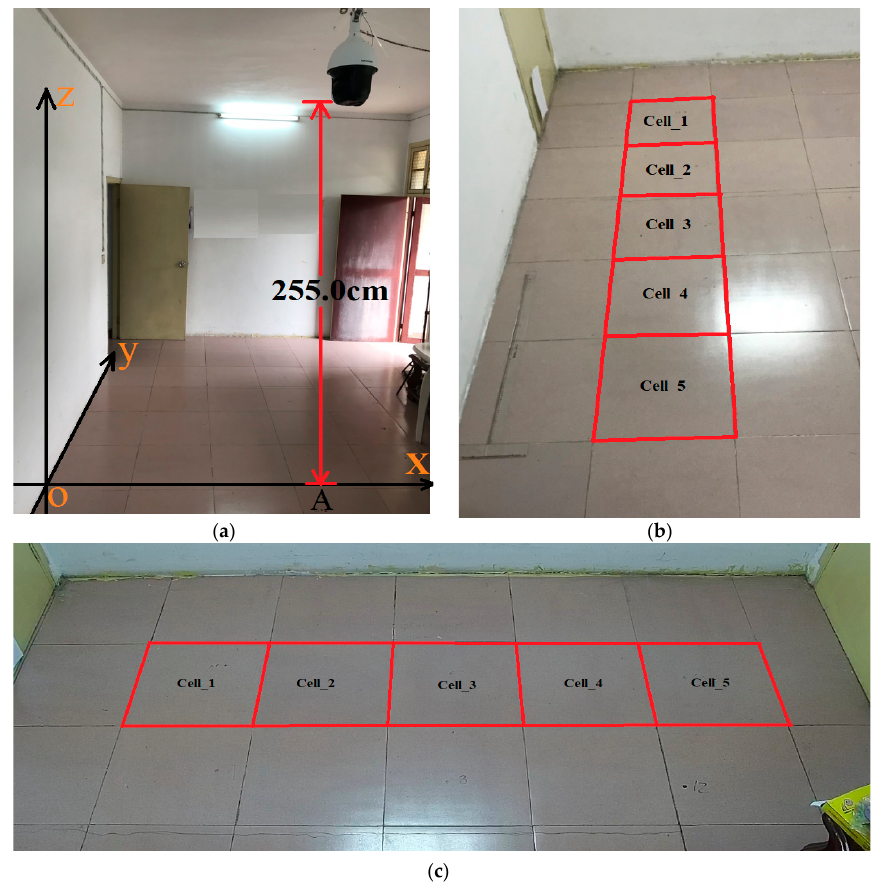
Figure 11. Experimental scene. ( a ) Experimental scene modeling. ( b ) Vertical channel. ( c ) Horizontal channel.